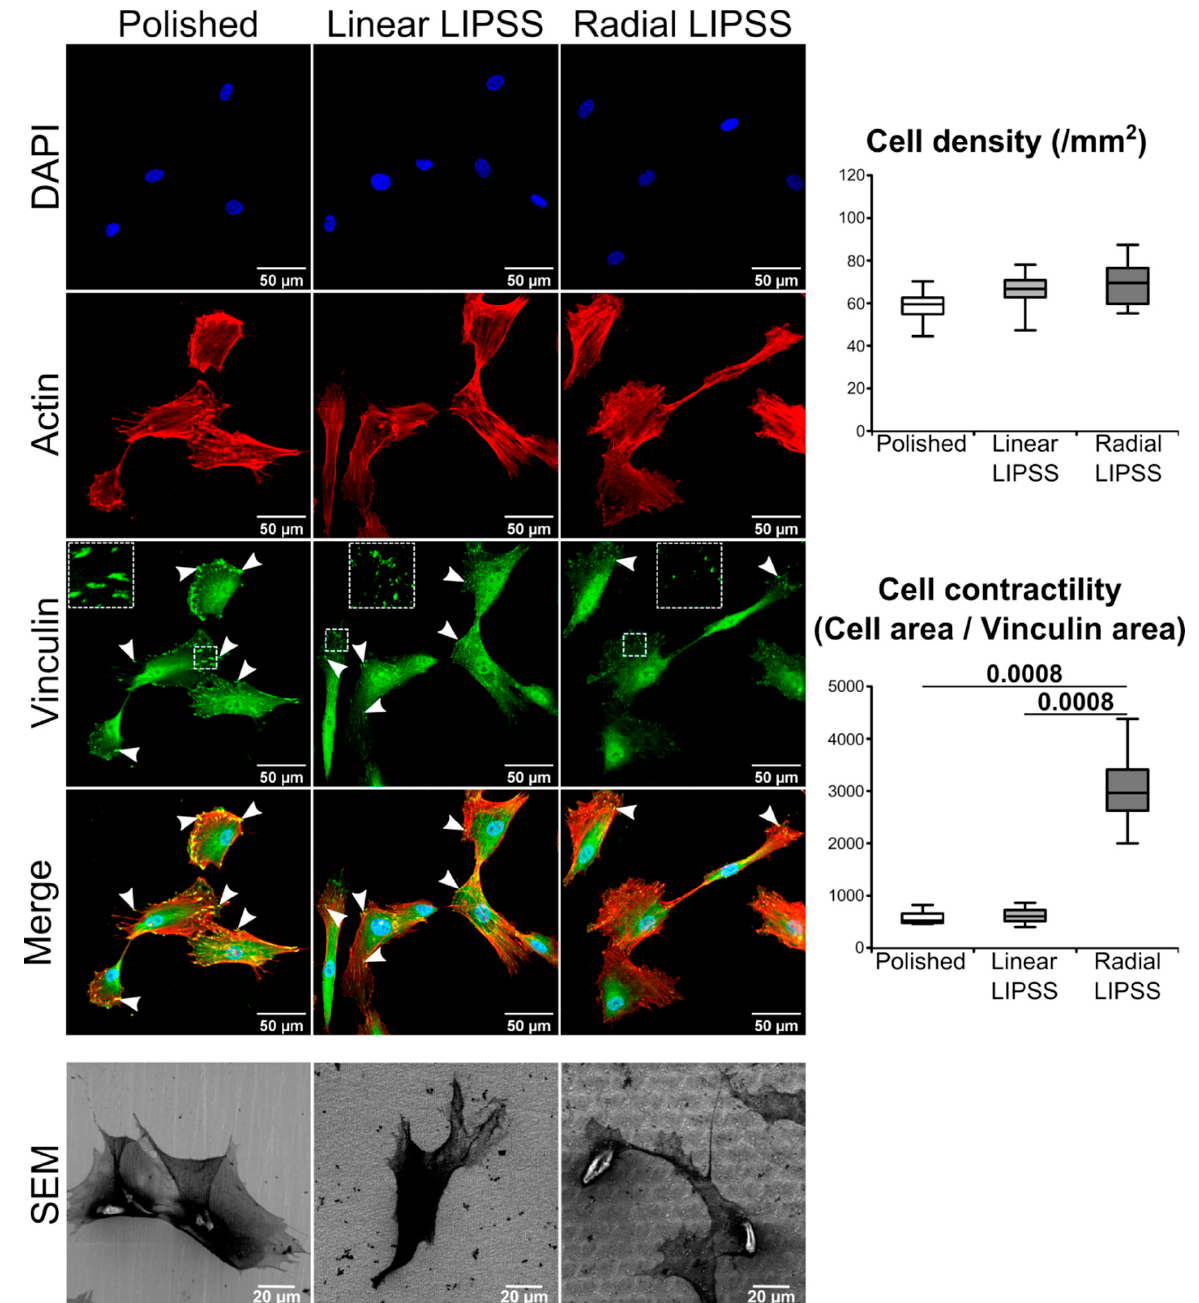
Figure 2. DAPI nuclear staining (blue), rhodamine-conjugated phalloidin-labeled actin (red), FITC-conjugated vinculin antibody (green), overlaid fluorescent image of immunostained cellular compo- nent (merged) for the cells cultured on polished, linear LIPSS and radial LIPSS surfaces 24 h post seeding. SEM images show other cells present on the three surfaces. White arrows indicate focal adhesions recognized by prominent vinculin labeling. The squares show a zoom of some focal adhe- sions for each surface. On the right side of the image are the results of cell density and contractility for the three surfaces. The graphs show the p -values between each group, Mann–Whitney U test, n = 8